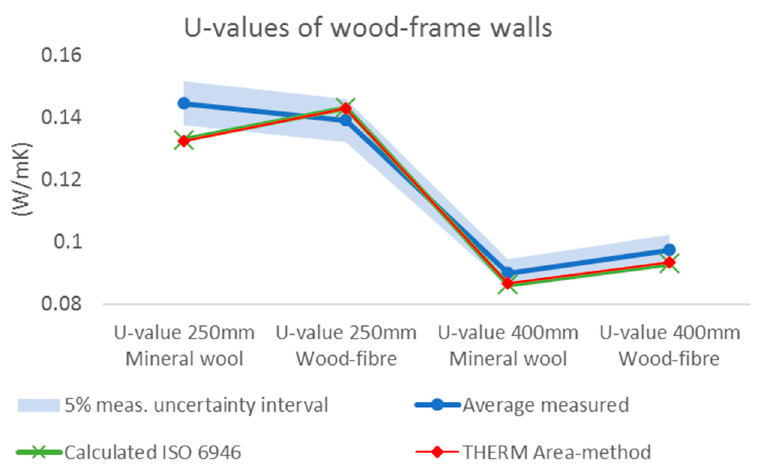
Figure 5. Calculated U-values of wood-frame walls. The calculations are performed according to ISO 6946 and by using THERM. Table 5. Measured and calculated U-values for the different wall configurations.